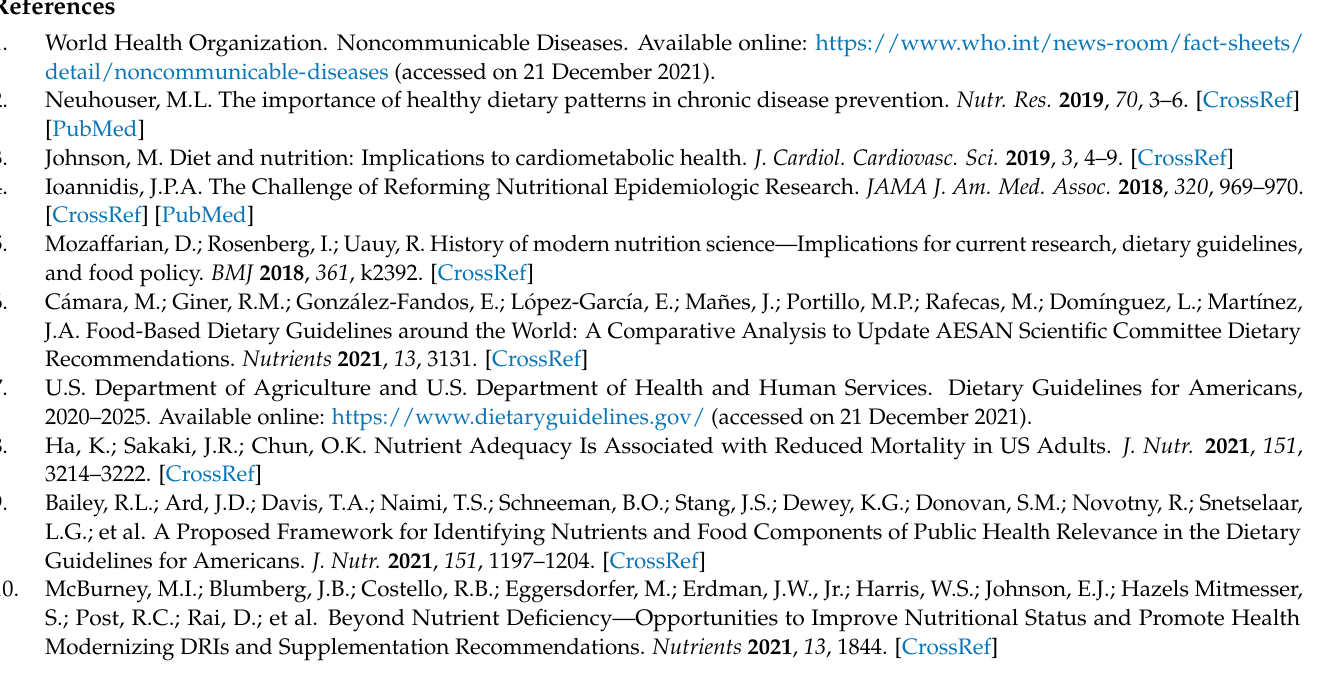
Figure S3: Sex-pairwise comparison of α diversity; Figure S4: Jaccard indices were used to explain β -diversity across the diet groups; Figure S5: Phylogenetic Unweighted UniFrac distances were used to explain β -diversity across diet groups; Figure S6: Heatmap representing hierarchical clustering analysis results at the feature level; Figure S7: Bacterial sex-dependent biomarkers of the female and male cohorts in each diet group according to the LEfSe at the feature level; Figure S8: PICRUSt2 results indicating differential predicted functional pathways between the bean-free and the bean-containing diet groups in the female cohort; Figure S9: PICRUSt2 results indicating differential predicted functional pathways between the bean-free and the bean-containing diet groups in the male